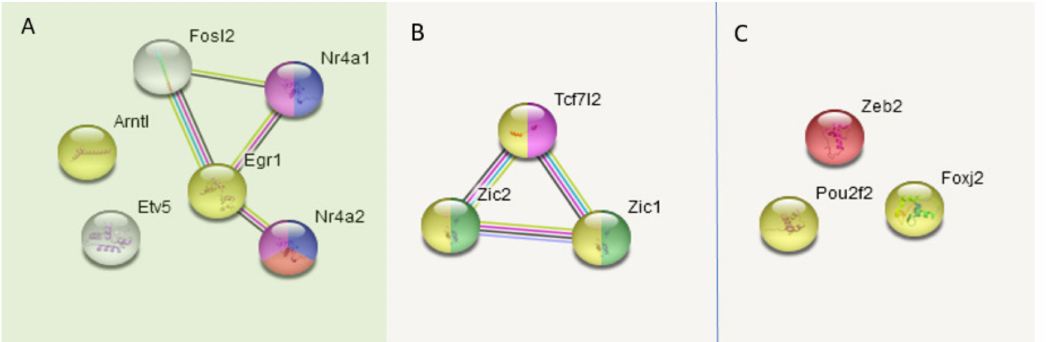
Figure 3. GO annotation of 12 TFs split into three corresponding clusters ( A – C ) (Figure 2). Overall PPI enrichment p -value (7 edges vs. 1 exp): 5.23 × 10 − 6 . Green shaded area ( A ) is a control-group- associated cluster (Figure 2). Color coding: yellow—KW-0010: activator, 7 genes; FDR < 2.4 × 10 − 6